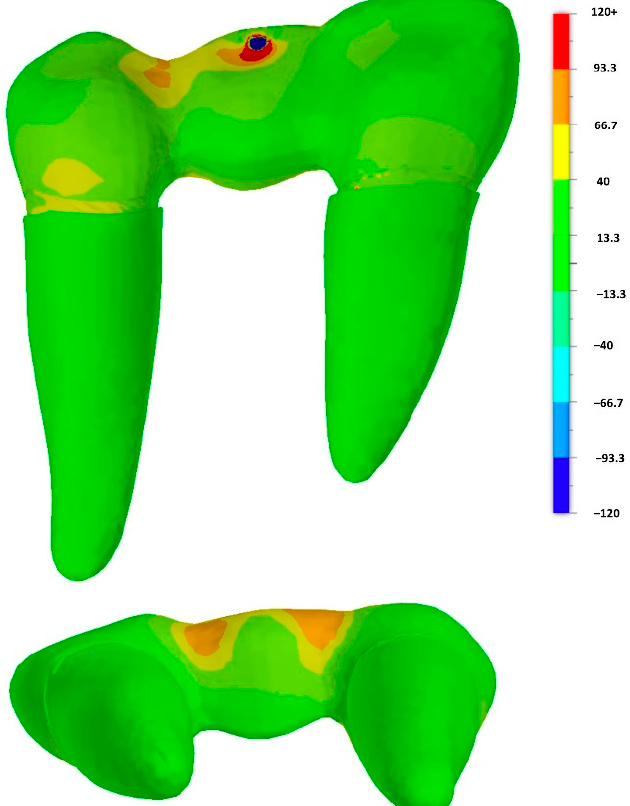
Figure 7. FE analysis: principal stress [MPa] distribution within the restoration (central occlusal load direction).